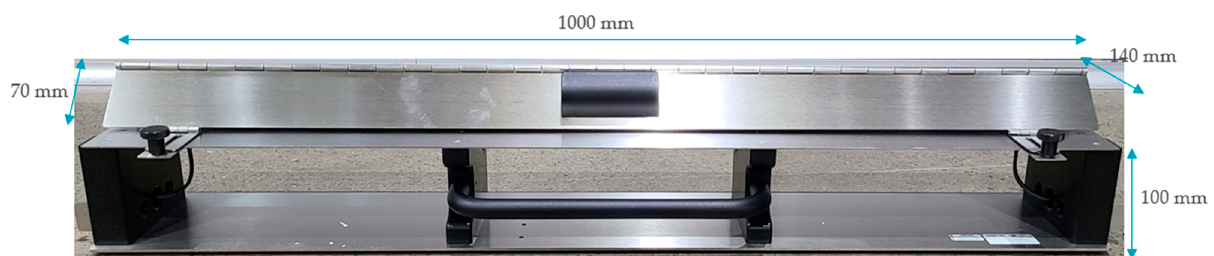
Figure 5. Architecture of the capacitive coupling clamp (CCC).